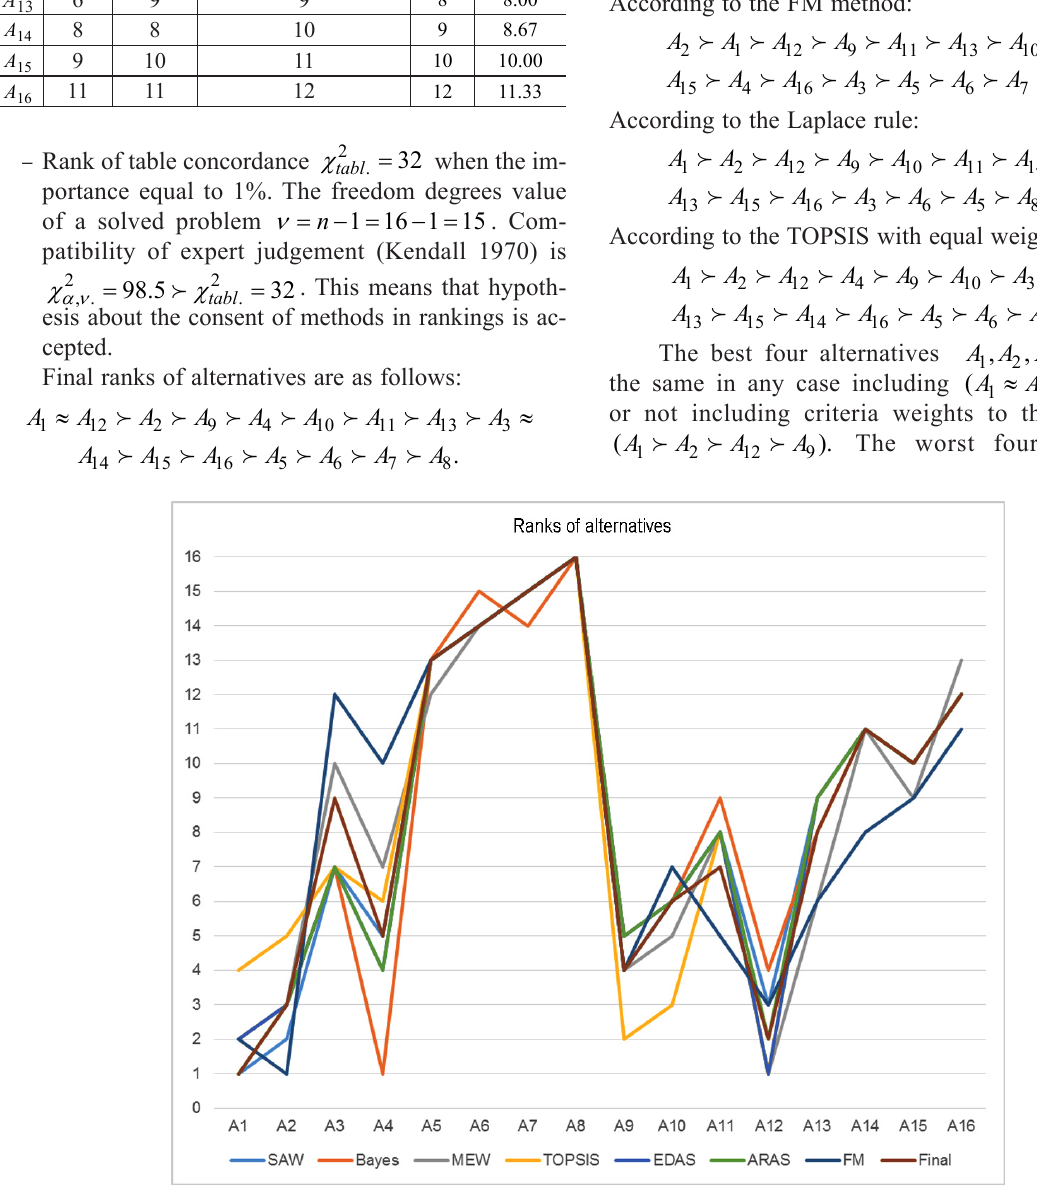
Fig. 4. Ranks of alternatives when weights of criteria are considered